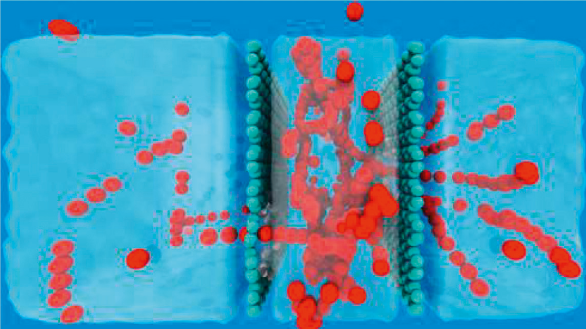
Figure 10: Schematic of RO membrane with nanopores [170].